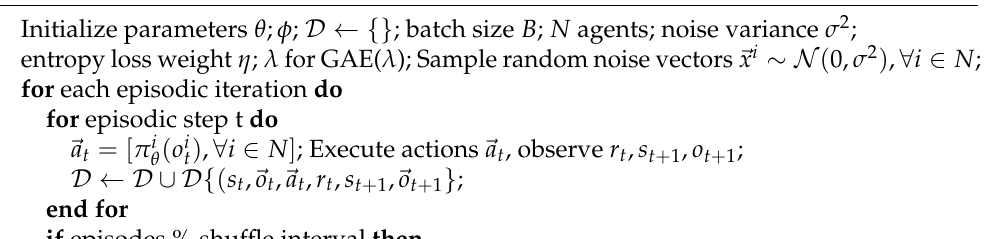
Figure A1. The framework of NV-MAPPO, whose noise-injection is different from NA-MAPPO. Algorithm A1